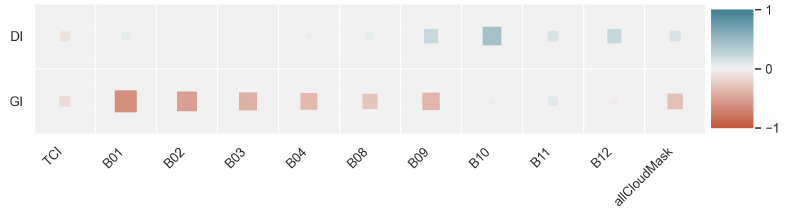
Figure 8. Overall correlation between GI, DI, and the Sentinel 2 sensor bands. Opacity and size of the squares reflect correlation intensity: large opaque squares denote strong correlations, and small translucent squares are attributed to weak or not correlated